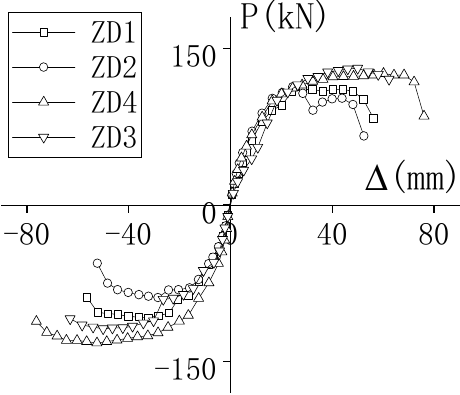
Figure 15. Backbone curve of specimens.